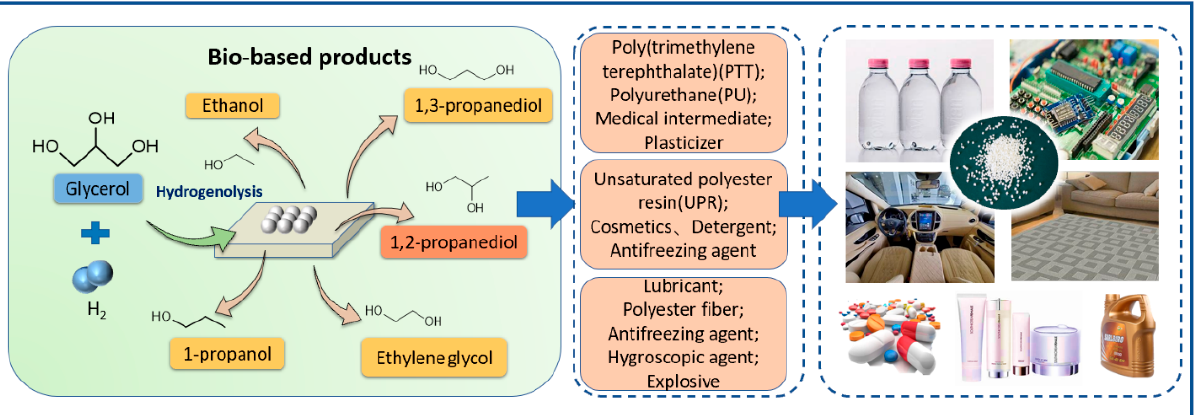
Figure 1. Hydrogenolysis products of glycerol.